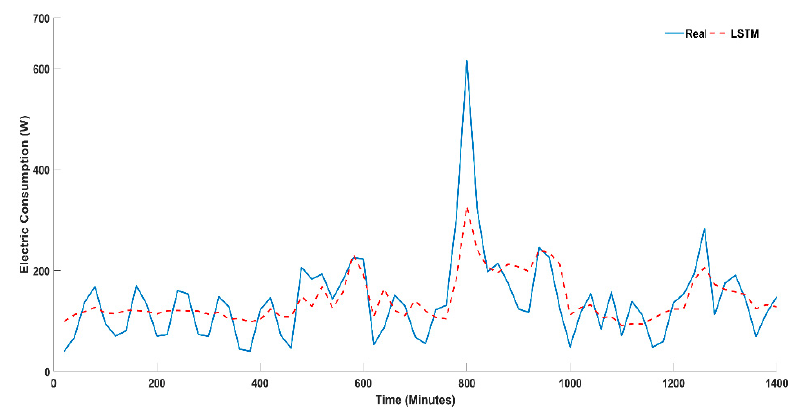
Figure 7. LSTM for multivariate time series.